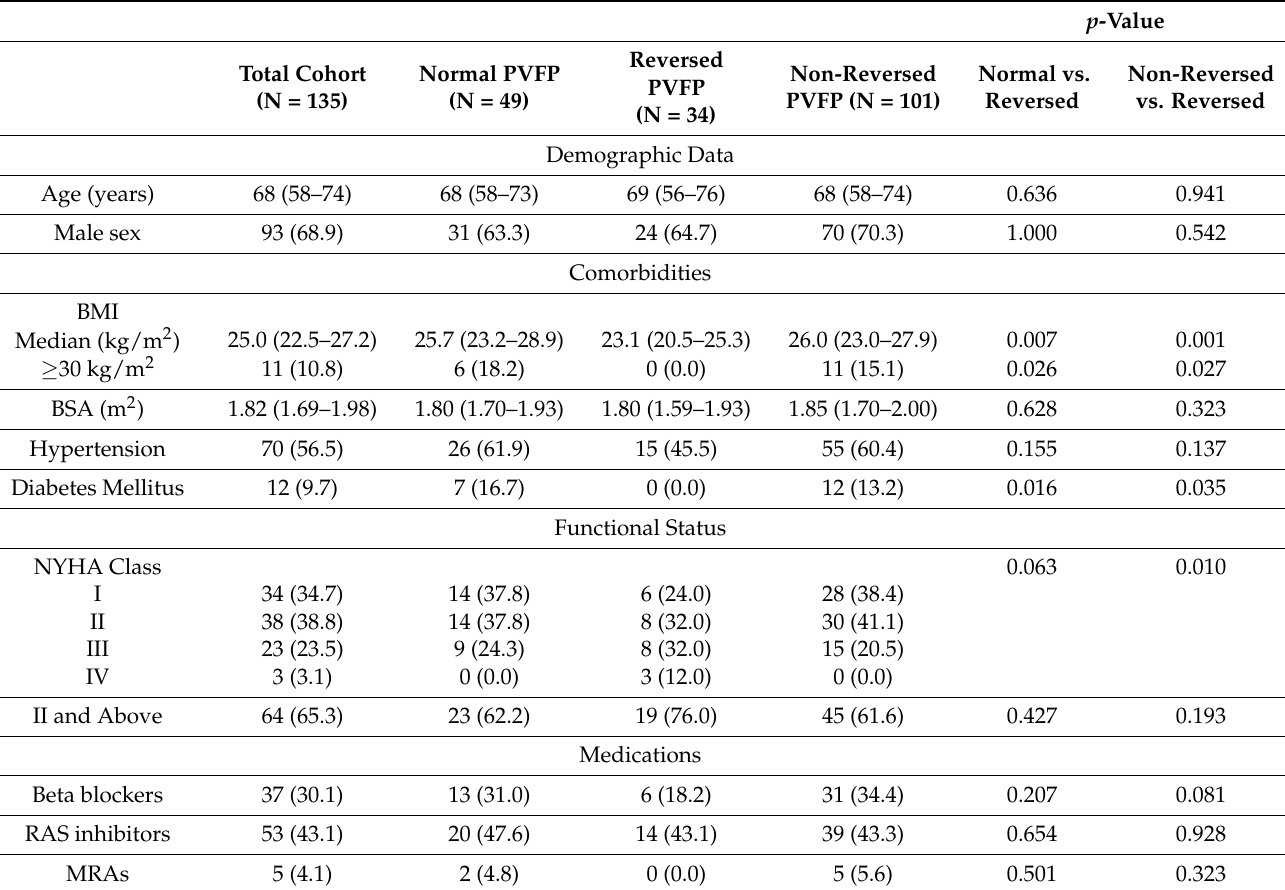
Table 1. Baseline Clinical Characteristics of the Study